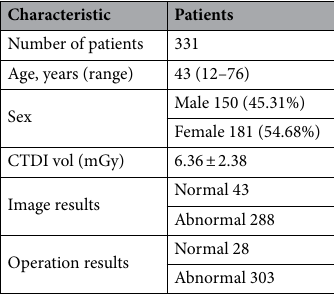
Table 1. The general information of 331